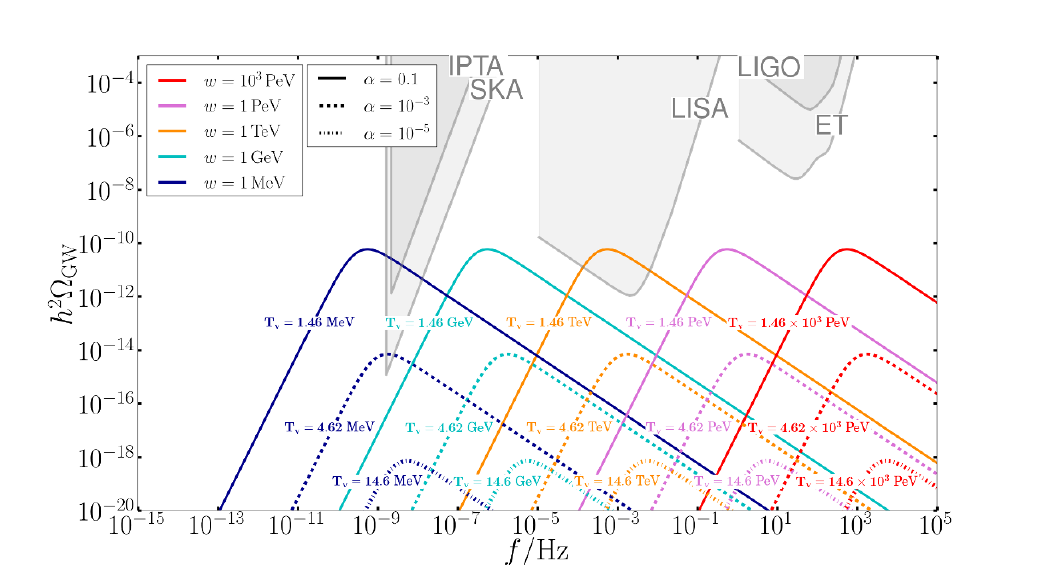
Figure 8 . Examples of the gravitational wave spectra emitted by tunnelling transitions in the absence of friction (due to the hidden sector being extremely cold, with (cid:15) (cid:25) 0). We show results for di(cid:11)erent values of the relative energy released by the transition compared to that in the visible sector: (cid:11) , as well as for di(cid:11)erent hidden sector scales w , and we (cid:12)x g = 2. For a (cid:12)xed (cid:11) the scale w determines the visible sector temperature at the time of the transition. In such models the bubbles walls runaway and gravitational waves are dominantly produced by the collision of bubbles. A signal is only observable for models in which (cid:11) is relatively